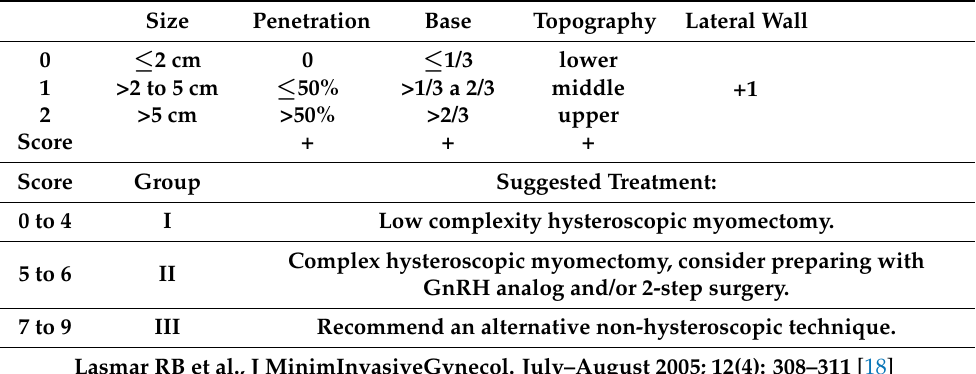
Table 2. Lasmar submucous myoma classification—STEPW classification